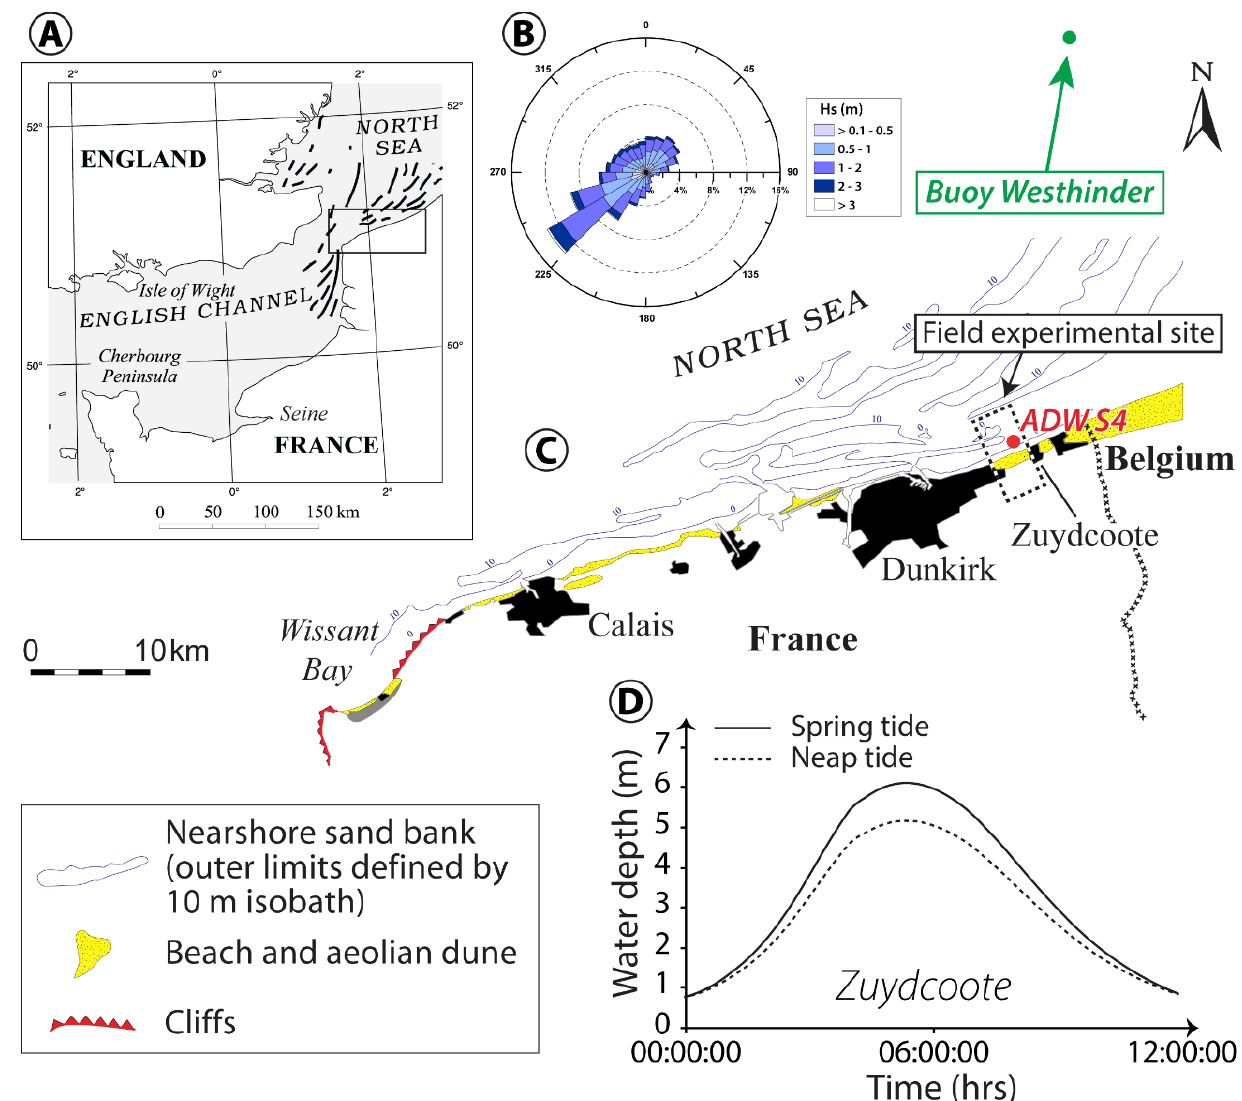
Figure 1. ( A ) Location of the study area showing the location of offshore sand banks. ( B ) Deep-water wave rose diagram based on hourly wave measurements from 1997 to 2016 at the Westhinder wave buoy; the green arrow indicates the location of the nearshore current meter. ( C ) Map of the study area and field experiment site. ( D ) Typical tidal curves for spring and neap tides at the study site.